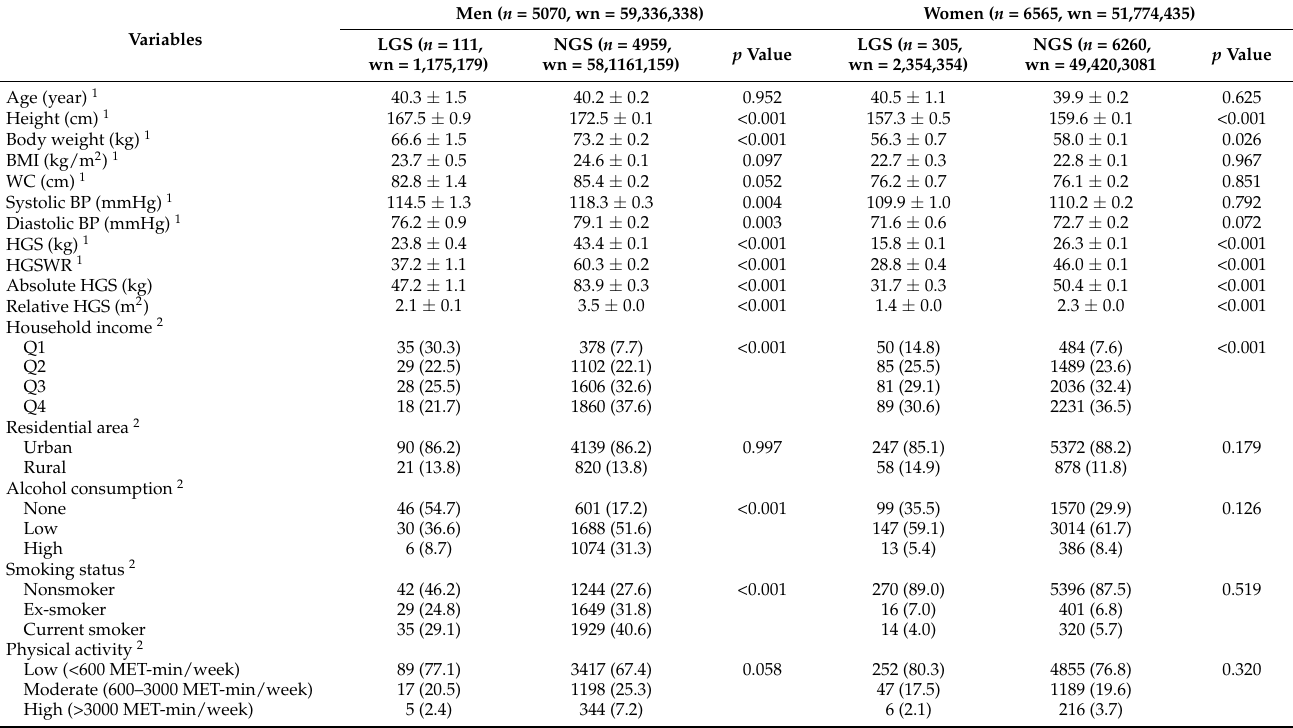
Table 1. Sociodemographic characteristics of the